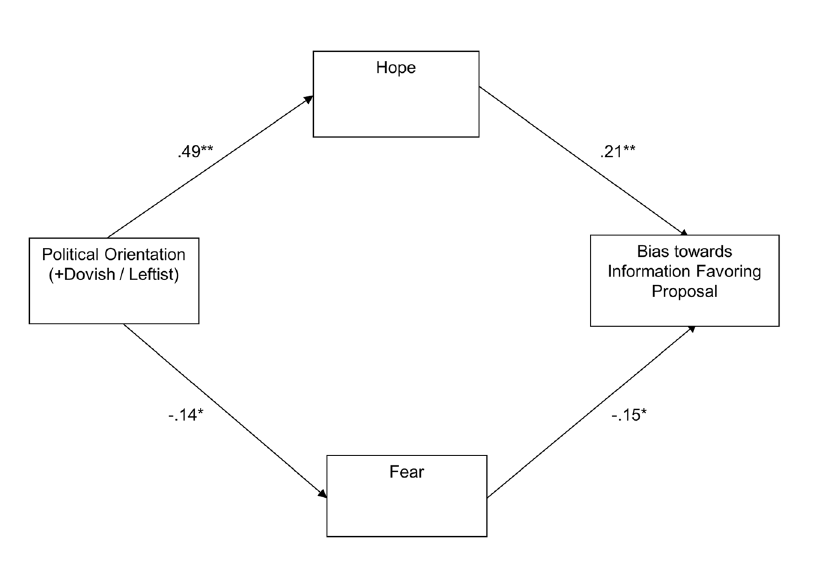
Figure 1. Indirect effect of political orientation on proportion of time spent on articles favoring the proposal through hope and